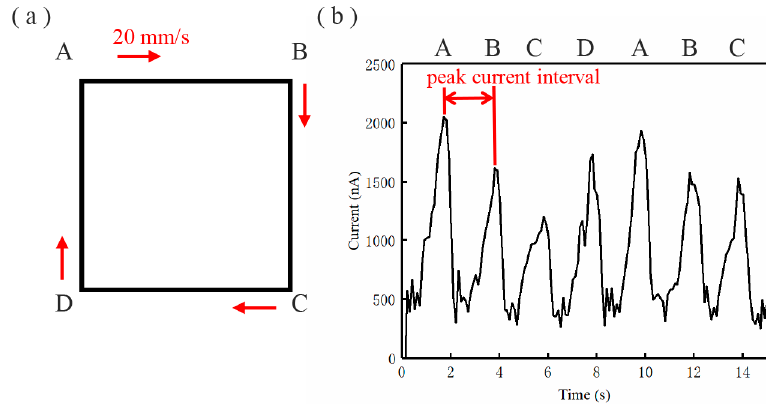
Figure 2. Micro/nano current in printing patterns: ( a ) motion trajectory of collector; ( b ) corresponding current waveform (applied voltage of 2 kV).